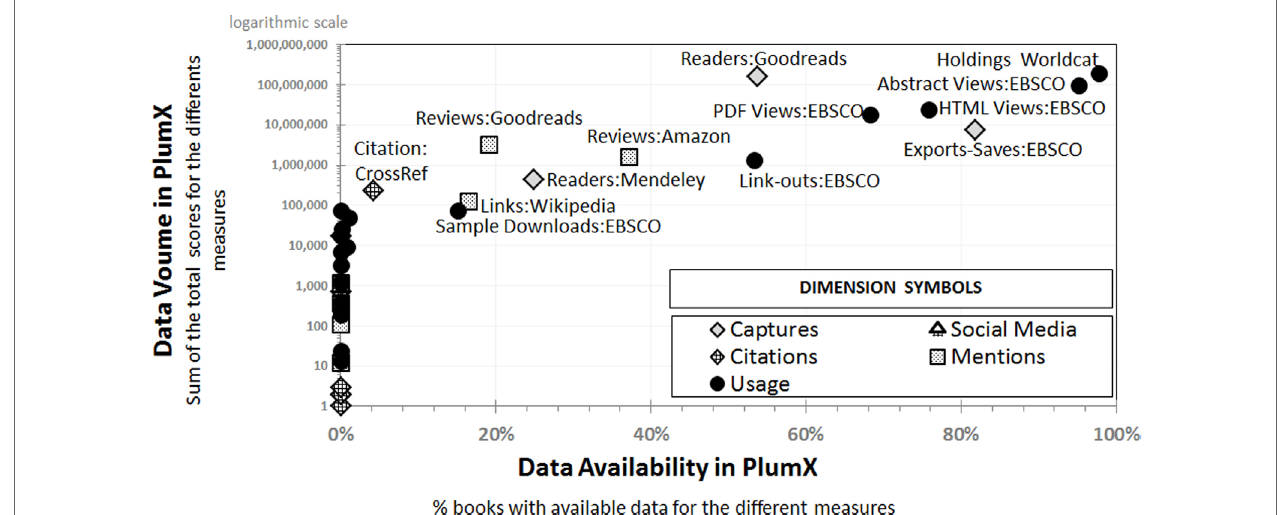
FigUre 3 | Synoptic overview of the PlumX results according to availability and